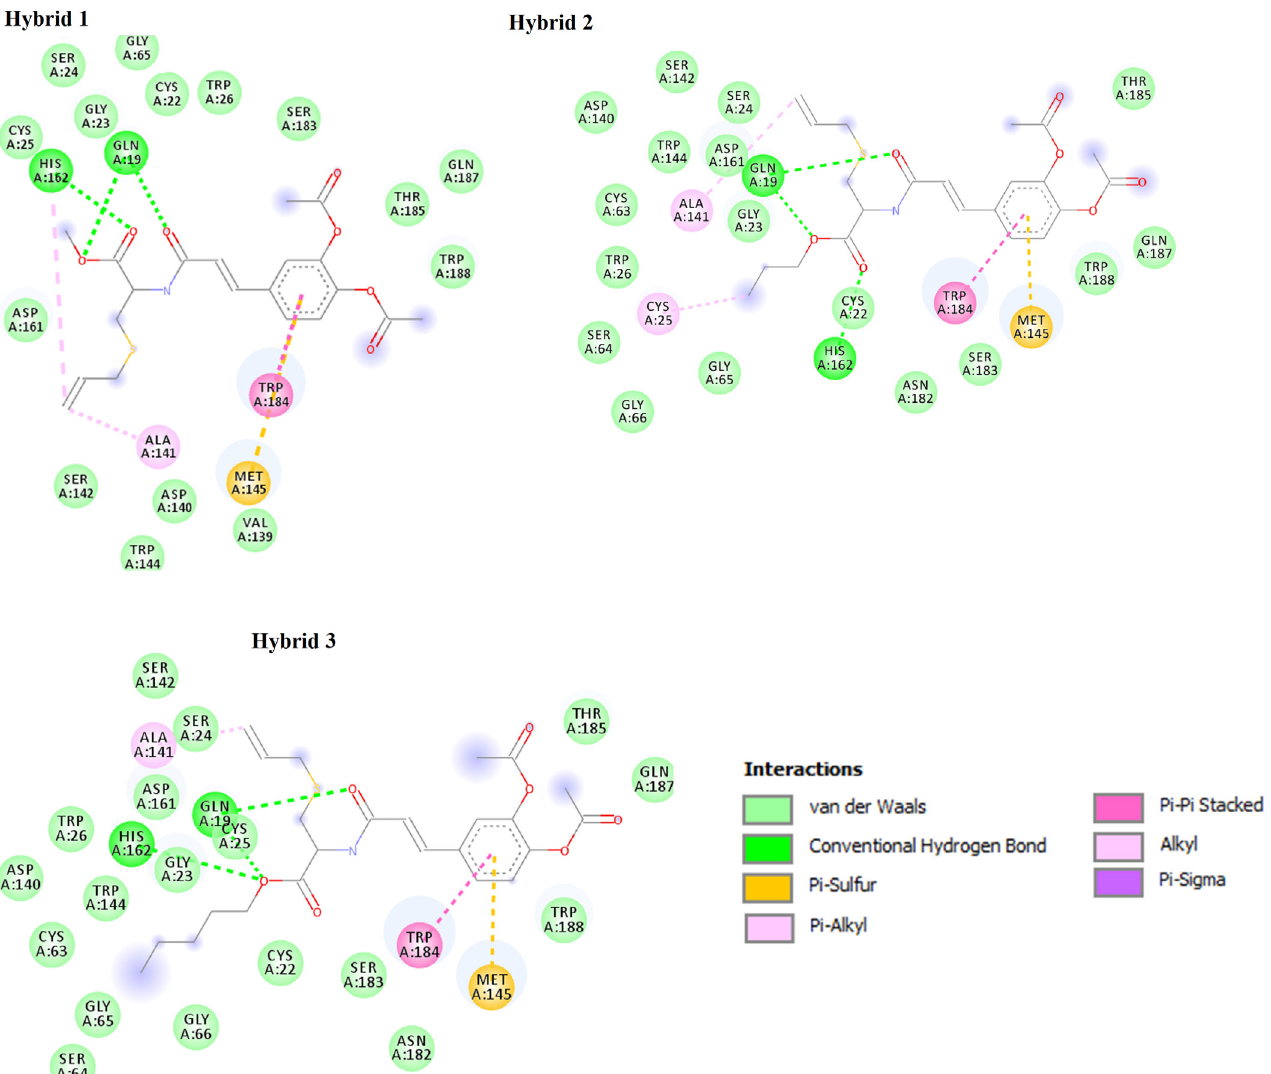
FIGURE 6 - Plotted protein-ligand interactions of hybrids 1 - 3 inside proteolytic pocket of Cruzipain. Dashed lines represent H-bonds and